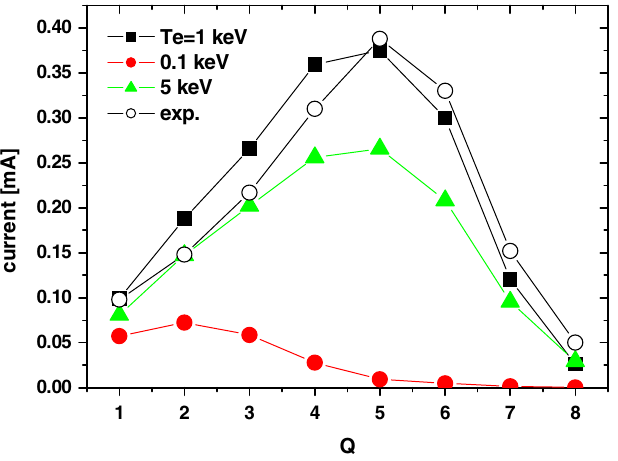
FIG. 2. (Color) Charge-state distributions of extracted neon ions for different electron temperatures. The gas pressure is 6 : 8 (cid:1) 10 (cid:2) 7 mbar . Open circles represent experimentally measured extracted ion currents from the